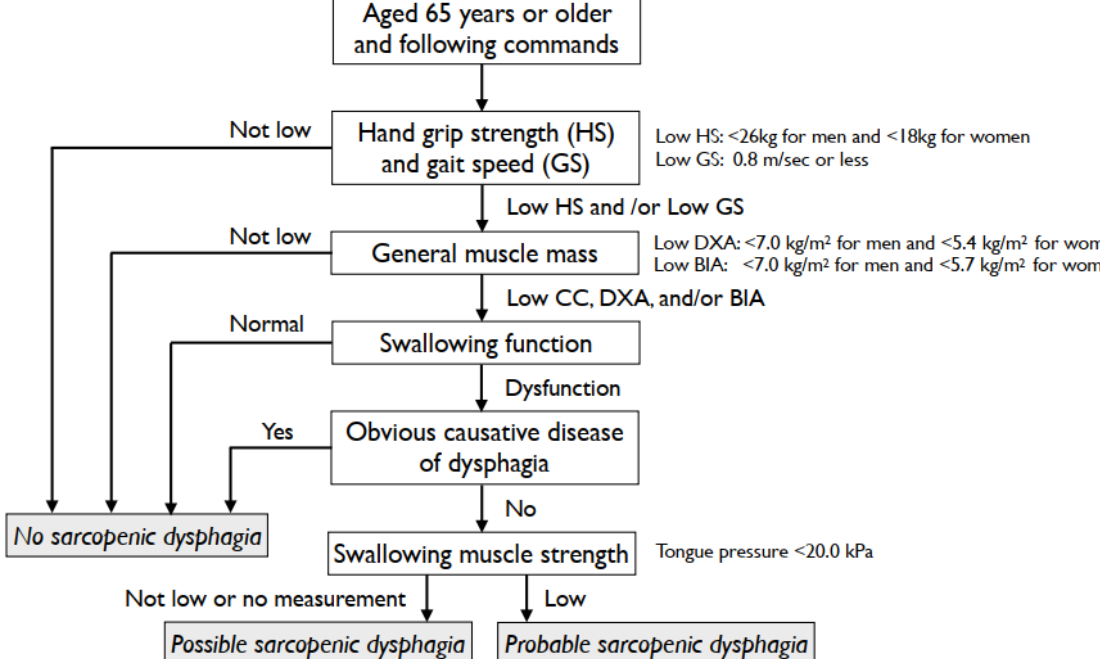
Figure 1. Diagnostic algorithm for sarcopenic dysphagia [11,12]. CC, calf circumference; DXA, dual-energy X-ray absorptiometry; BIA, bioimpedance analysis.